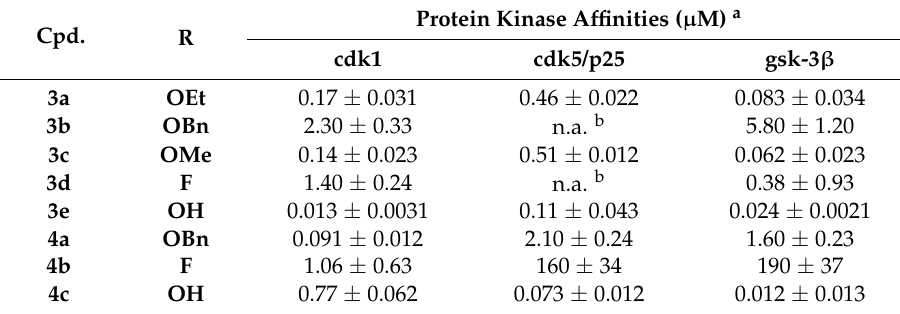
Table 1. Protein kinase affinities of target compounds 3a – e and 4a – c